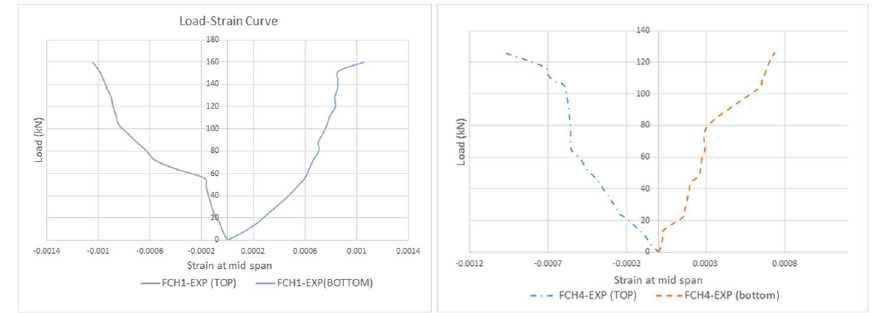
Fig. 15 Load-strain curves at mid-span for FCH1 and